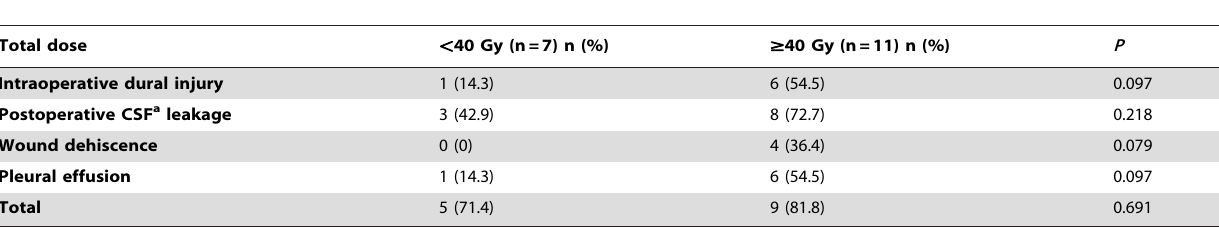
Table 4. Complication rates associated with total irradiation dose.